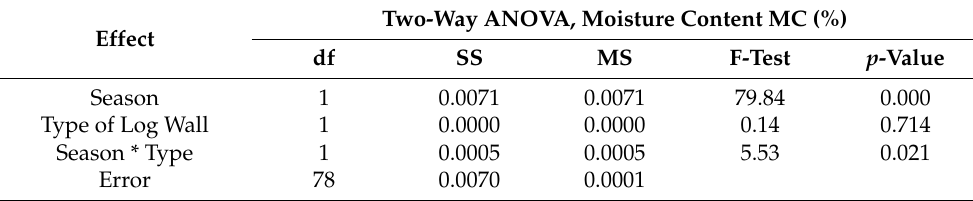
Table 6. Results of ANOVA for the insulation STEICO Flex part 3 width 50 mm.